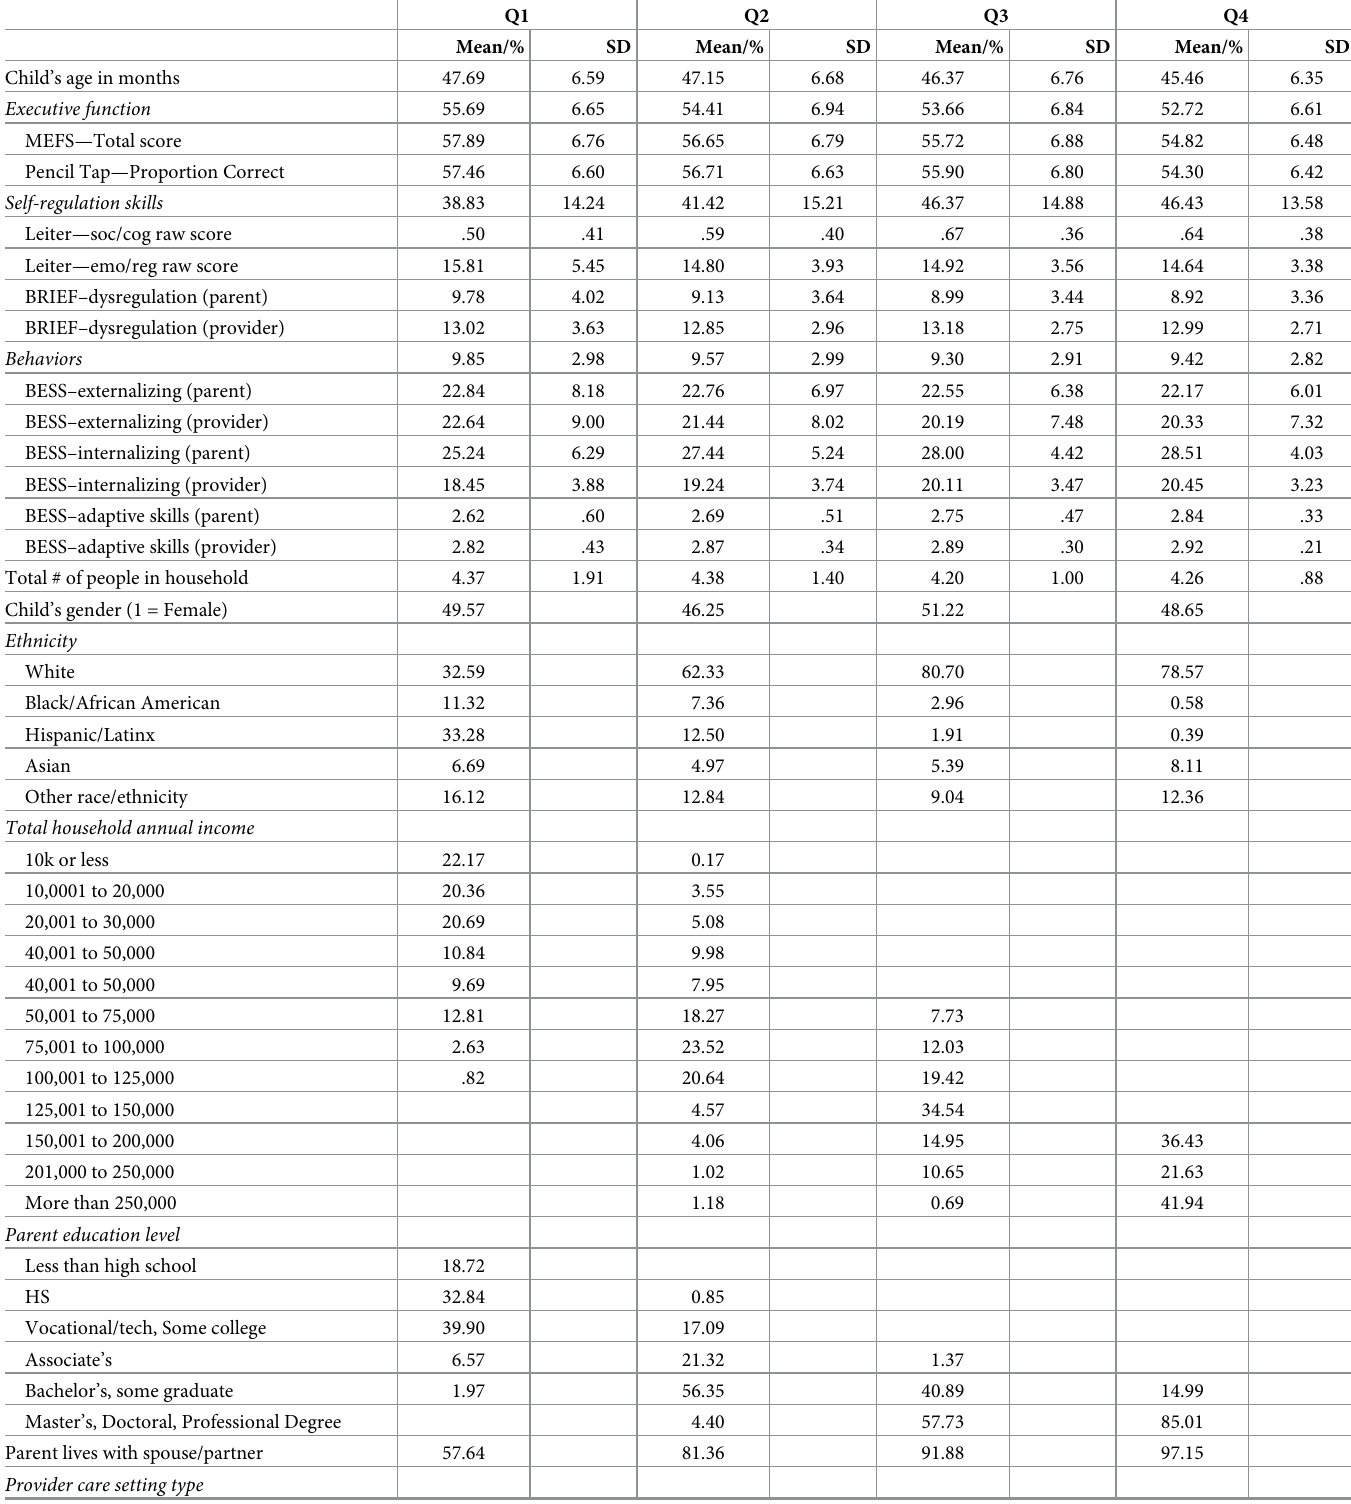
Table 2. Descriptive statistics by SES quartile (N =